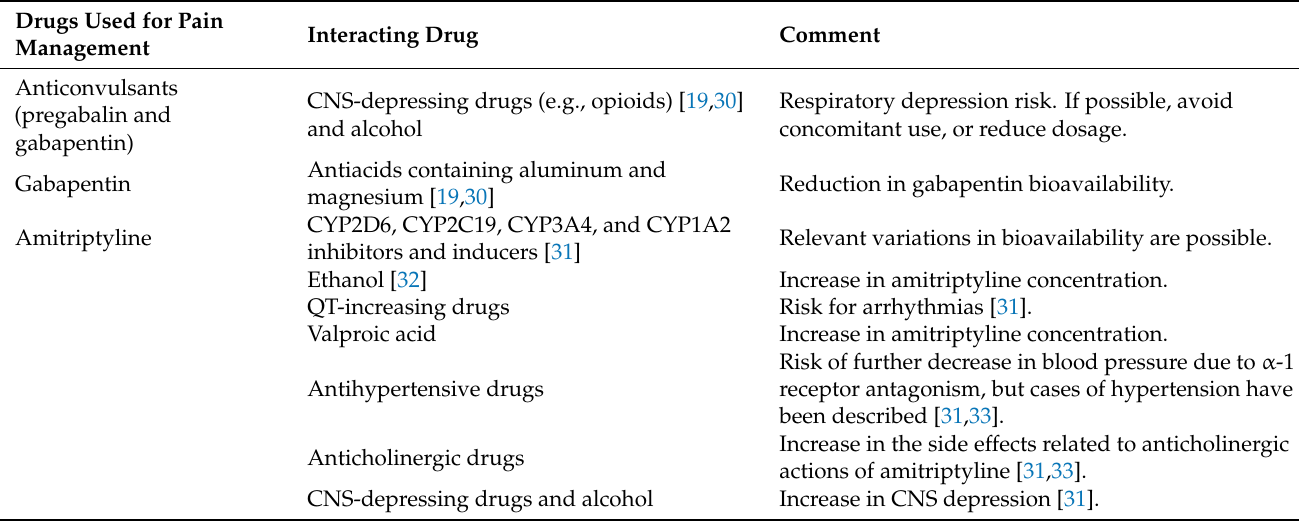
Figure 2. Antidepressants used for pain management. ( A ) Amitriptyline and SNRIs inhibit SERT and NET, blocking serotonin and noradrenaline reuptake and increasing the availability of the two neurotransmitters in synaptic cleft. The same action is shared by two opioids, non-antidepressant drugs, namely, tramadol and tapentadol. ( B ) Nevertheless, amitriptyline is associated with several side effects according to its inhibitory action on cholinergic, adrenergic, and histaminergic path- ways. Ach, acetylcholine; AchE, acetylcholinesterase; COMT, catechol-O-methyltransferase; MAO, monoamine oxidase; NET, norepinephrine transporter; SERT, serotonin transporter; SNRI, serotonin and norepinephrine reuptake inhibitors. Table 2. Possible drug interactions in patients with chronic pain using analgesic or anti-inflammatory